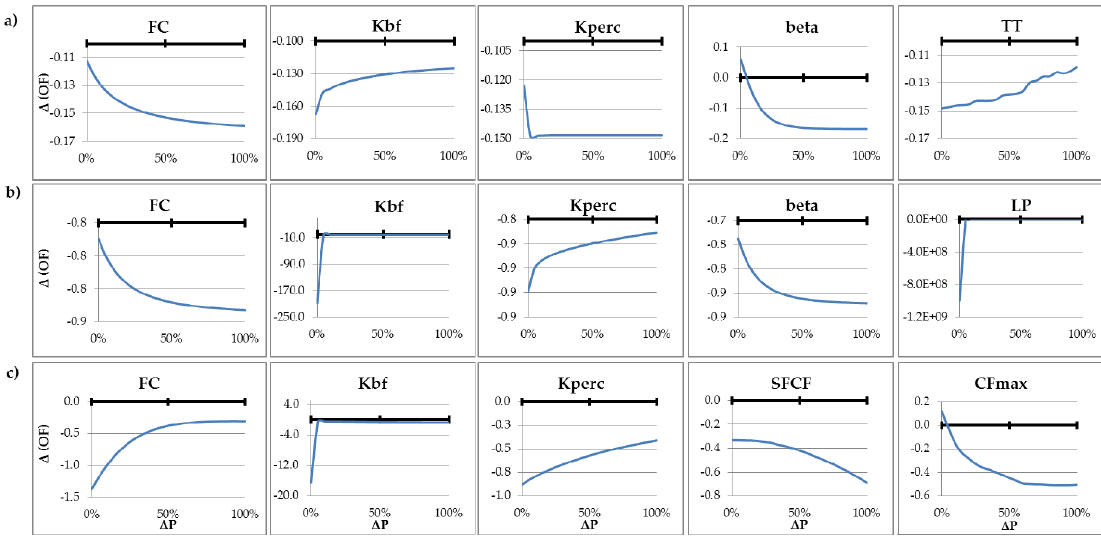
Figure 5. Sensitivity analysis in different basins: ( a ) Ajichai; ( b ) Lighvan; and ( c ) North Fork.